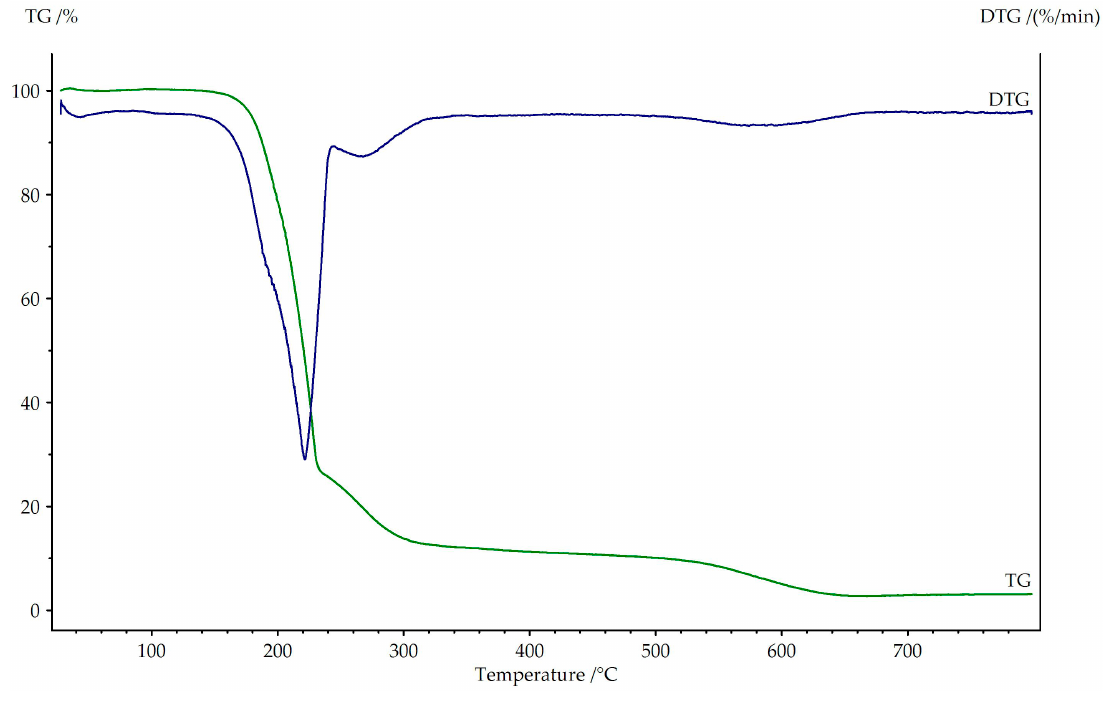
Figure 3. TG-DTG curves of organic ligand.